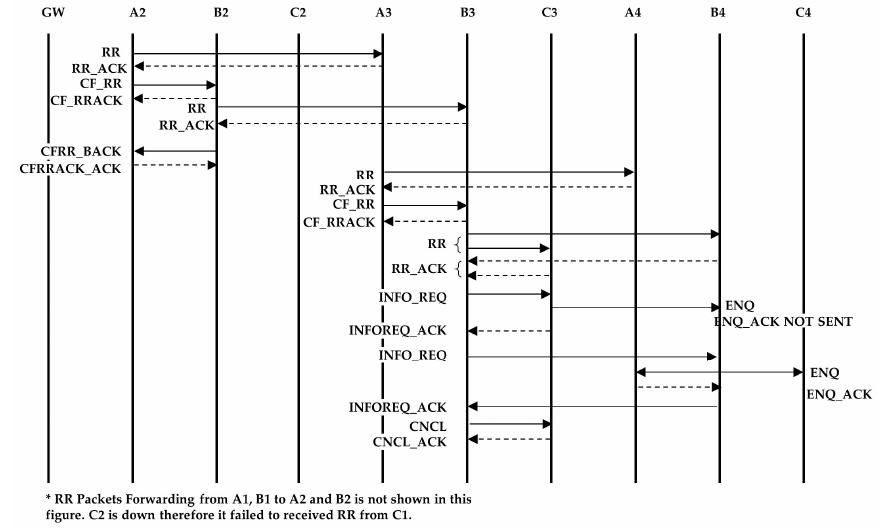
Figure 10. Sequence of messages to determine the correct node for string formation.